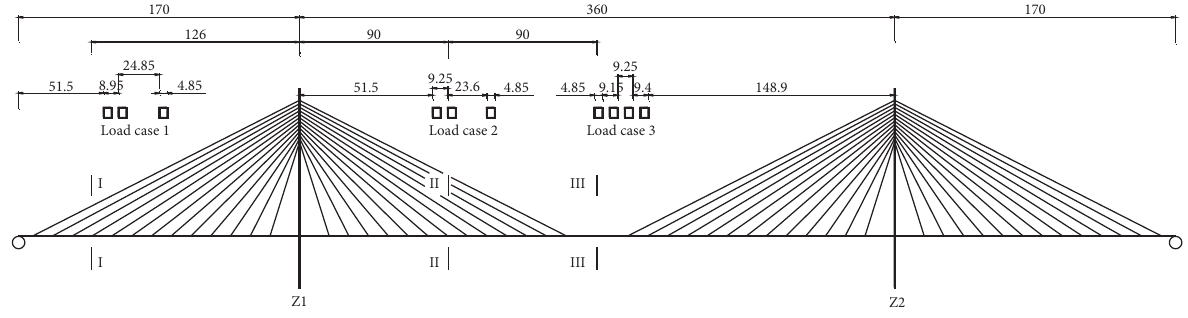
Figure 10: Longitudinal view and load paths (units: m). Table 3: Vertical displacement of sections for the three load